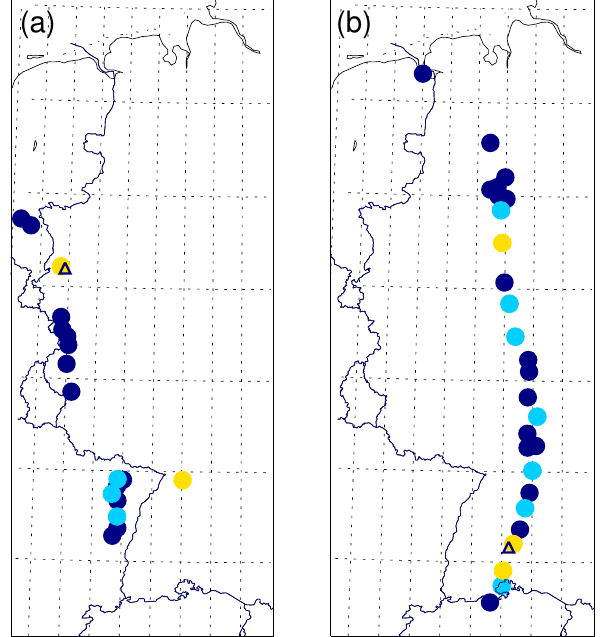
Figure 5. KONRAD analysis hailflag (thick dark blue, light blue and yellow triangles) for all QC1 and QC2 hail entries (summer 2010) in the ESWD. Thin triangles show hail reports with no KON- RAD cell within 20km and ± 5min.